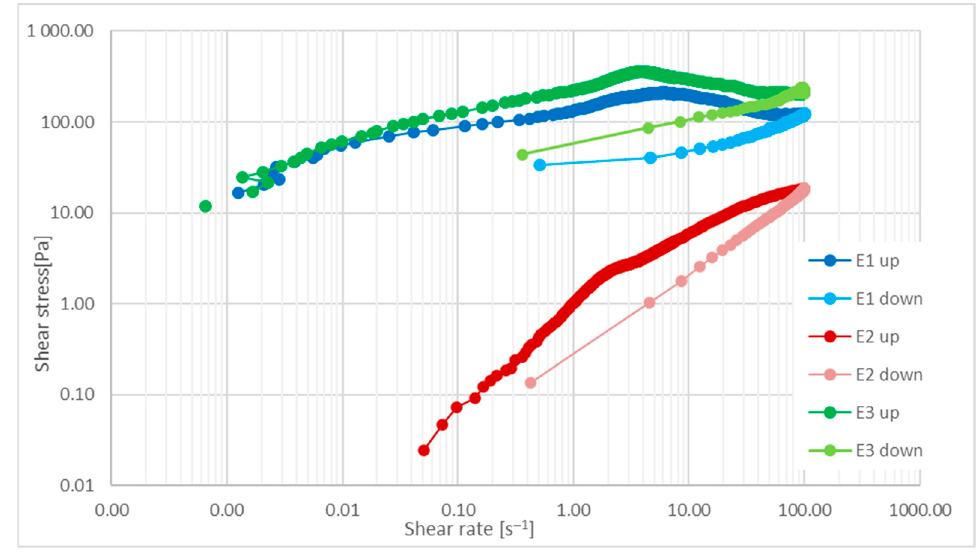
Figure 9. Flow curves of samples E1–E3. Table 5. Basic rheological properties for samples E1–E3 and textural profile. Table 5. Basic rheological properties for samples E1–E3 and textural